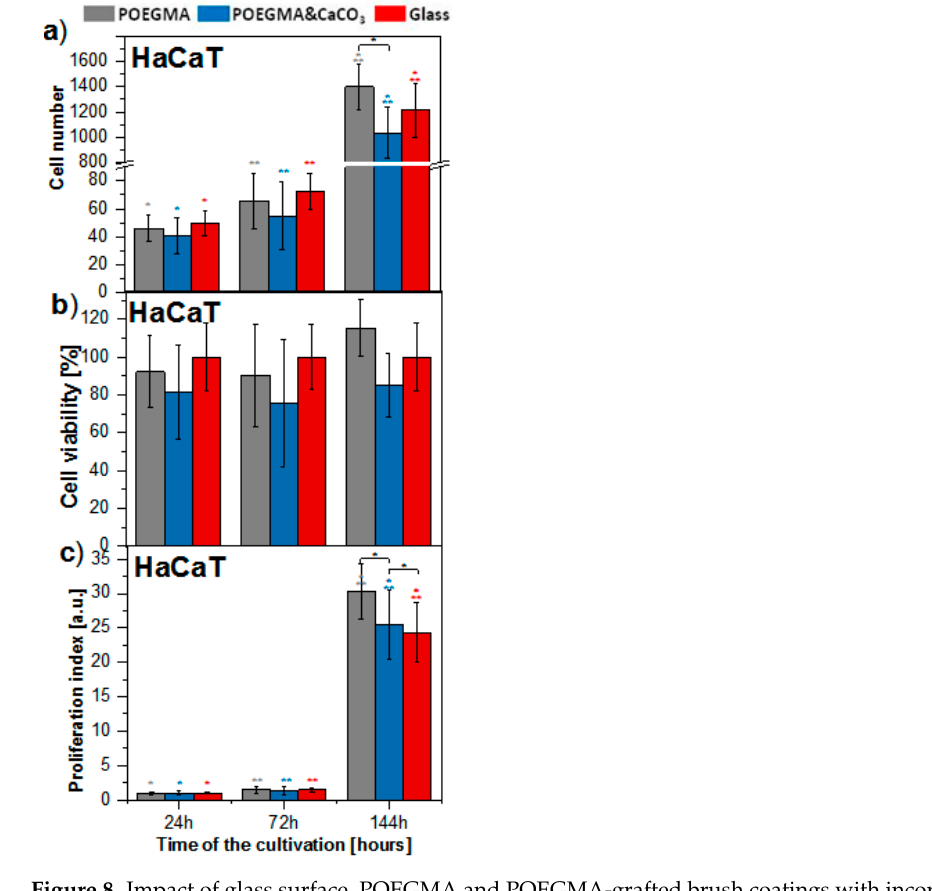
Figure 9. Fluorescence images of cancerous WM35 cells after 24 ( a – c ), 72 ( d – f ) and 144 h ( g – i ) of cultivation on glass surface ( c , f , i ), POEGMA ( a , d , g ) and POEGMA-grafted brush coatings with incorporated CaCO 3 NPs ( b , e , h ).